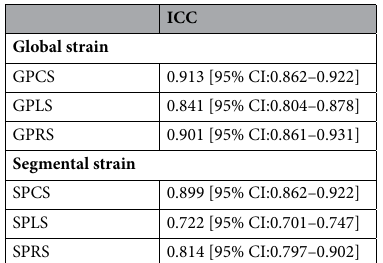
Table 2. Interobserver agreement. GPCS/SPCS global/segmental peak circumferential strain, GPLS/SPLS global/segmental peak longitudinal strain, GPRS/SPRS global/segmental peak radial strain.